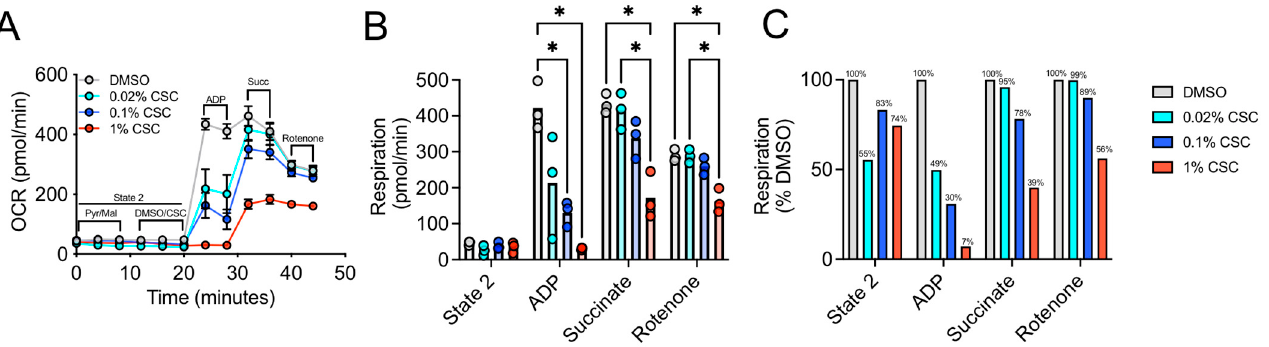
Figure 2. Impact of acute CSC treatment on mitochondrial respiratory function. ( A ) Seahorse analysis of mitochondrial respiration indicating addition of drugs/substrates/inhibitors. ( B ) Quantification of respiration based on conditions for each dose of CSC. ( C ) Changes in respiration presented as a percentage of the DMSO control group. (N = 3/group) Two-way ANOVA (including Tukey’s post hoc testing) was conducted via GraphPad Prism (version 9.0.2), * p < 0.05 as statistically signif-